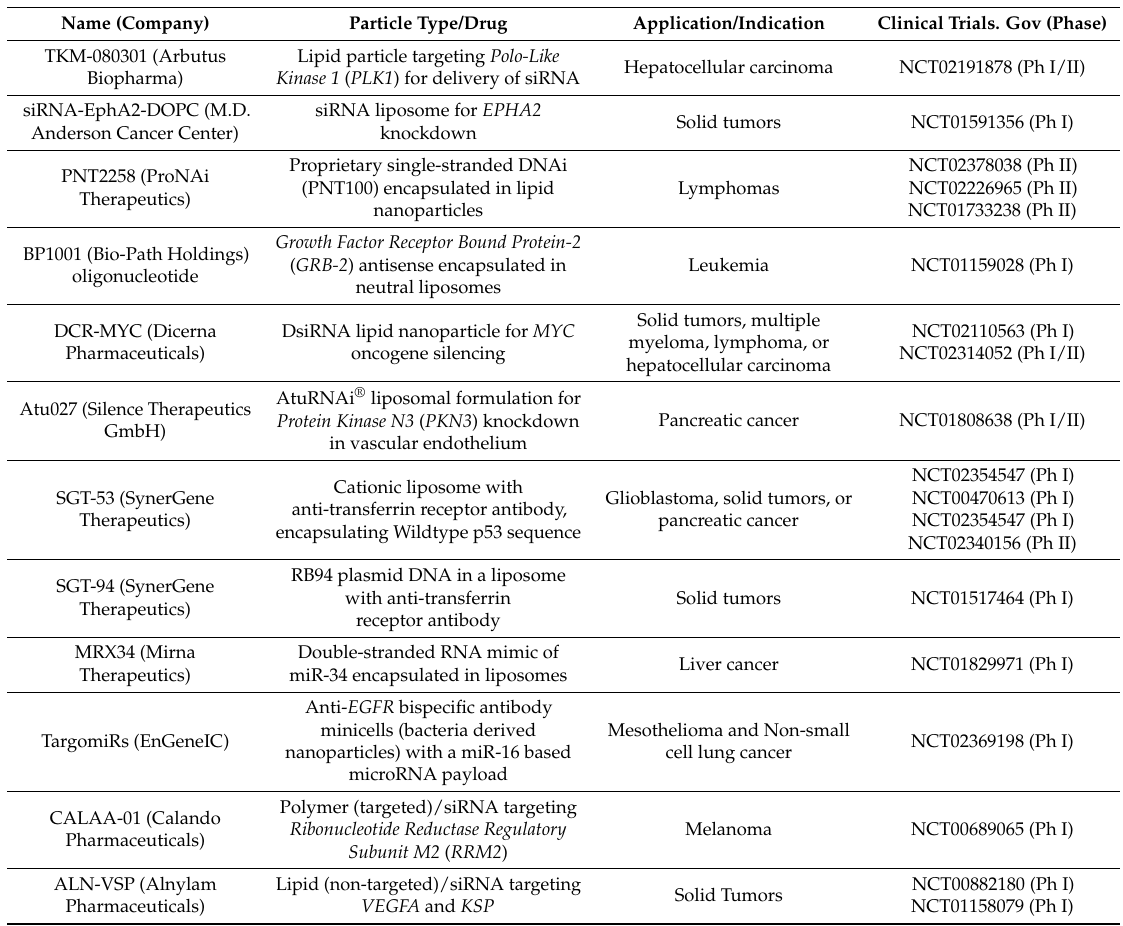
Table 2. Gene silencing nanoparticles (NPs) undergoing clinical trials for cancer treatment (adapted from